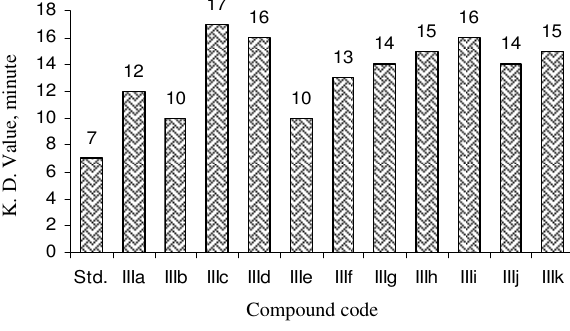
Figure 1. Insecticidal activity of